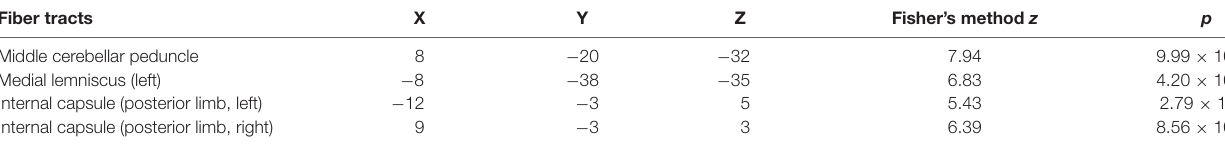
TABLE 2 | Montreal Neurological Institute (MNI) coordinates of peak voxels for white matter tracts.